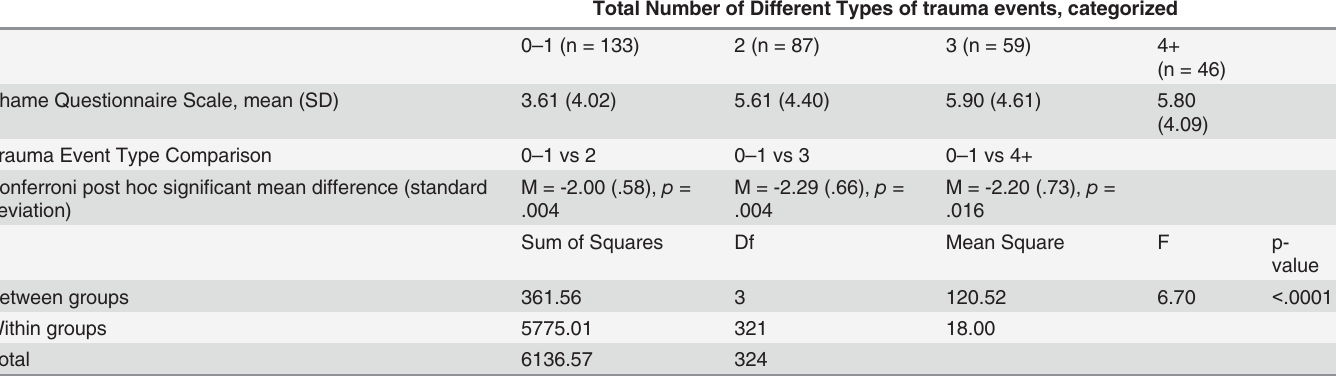
Table 3. Evaluation of Criterion Validity: Analysis of Variance Comparing the Shame Questionnaire Score Between Number of Traumatic Event